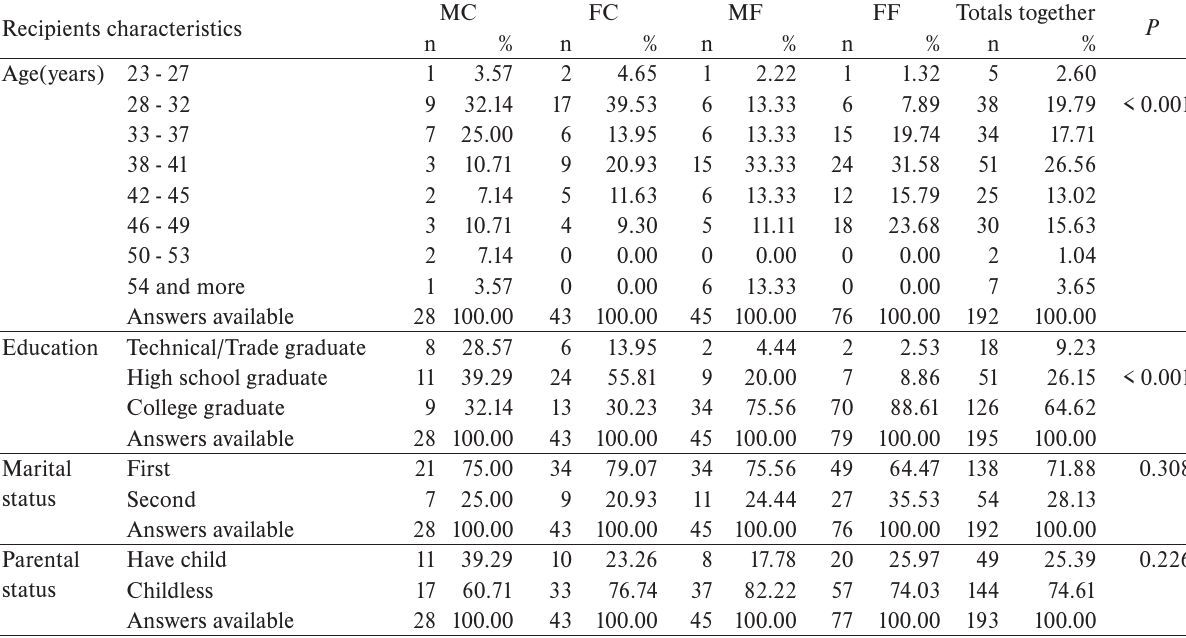
Table 1. The background characteristics of the recipients of donated gametes; P-values represents hypothesis testing based on Pearson Chi-square